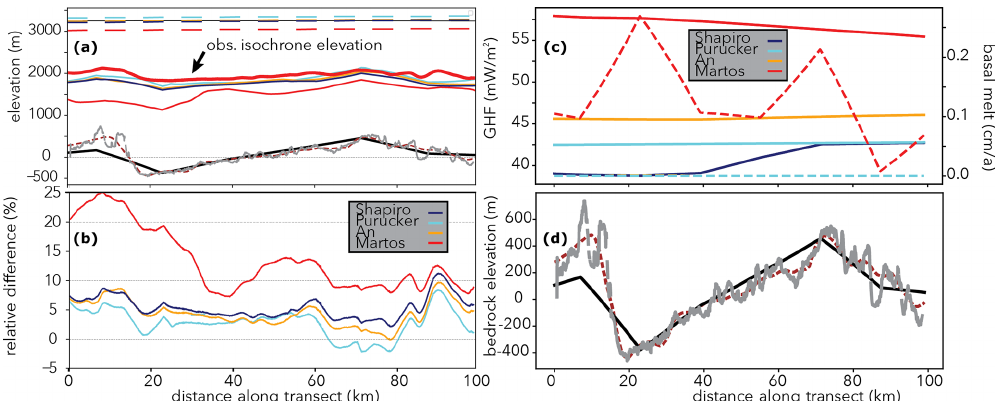
Figure 8. Illustration of model data along DC-X57a transect with a temperature–precipitation scaling of 3%K − 1 . Panel (a) shows the modelled surface (dashed lines; observed ice surface is depicted by the thin black line) and isochrone elevation under geothermal heat flux boundary conditions from Shapiro and Ritzwoller (2004), Purucker (2013), An et al. (2015), and Martos et al. (2017). Panel (b) depicts the isochrone mismatch (normalised by local ice thickness) between modelled and observed isochrone elevations. Panel (c) shows the geothermal heat flux along the transect and the associated modelled basal melt (dashed lines). Panel (d) highlights the bedrock elevation from the model simulation based on Bedmap2 (Fretwell et al., 2013) at 16km resolution (black line), bedrock radar reflection (Cavitte et al., 2016) (grey line) and BedMachine Antarctica (Morlighem et al., 2020) data at 1km resolution (dashed red